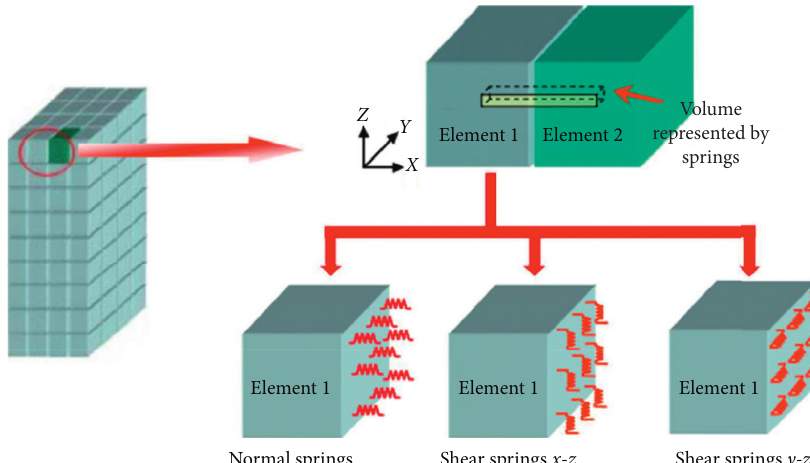
Figure 1: Element connections in AEM.